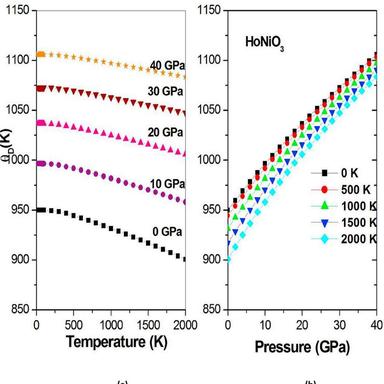
Debye temperature θD as a function of the temperature (pressure) at different given pressures (temperatures).